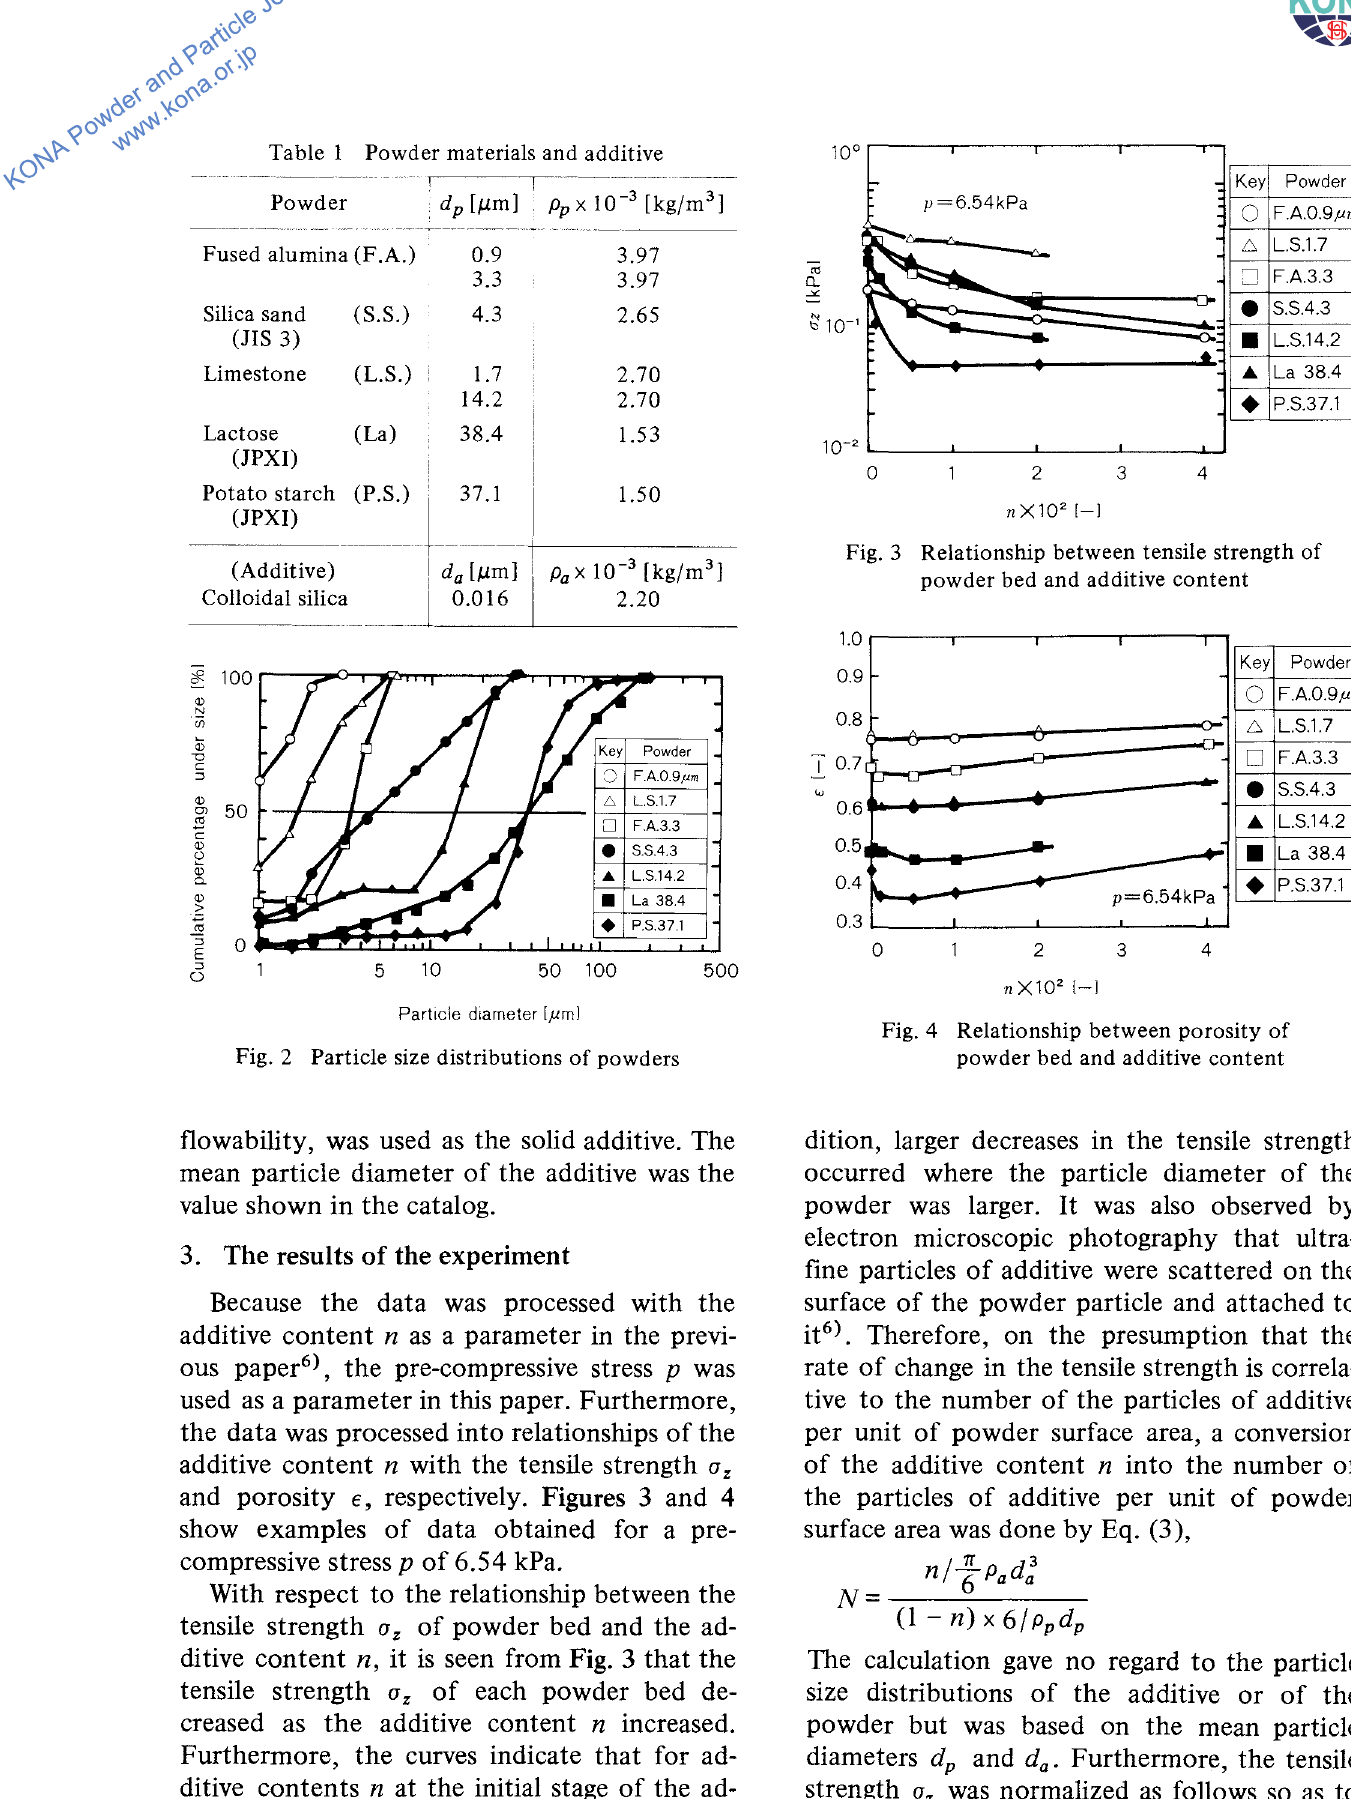
Fig. 3 Relationship between tensile strength of powder bed and additive content